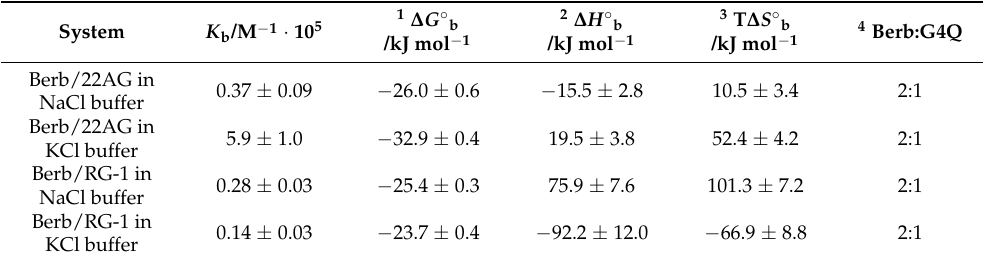
Figure 4. Binding isotherms for the Berb/22AG (panel ( A , B )) and Berb/RG-1 (panel ( C , D )) systems obtained from fluorescence spectroscopy in 30 mM Tris buffer, pH 7.4, with the addition of 100 mM NaCl or KCl. The berberine concentration was 15 µ M and the concentration of G4Qs was varied between 0 µ M and 40 µ M. The berberine was excited at 443 nm, the emission was collected at the maximum of emission, at 536 nm. The red lines represent the best fit of the experimental data according to an equivalent and independent binding sites model. According to the Job’s plot data, the stoichiometry was 2:1 (Berb:G4Q) in all cases. All the experiments were performed at 25 ◦ C and 1 bar. Table 1. Thermodynamics parameters for the complex formation between berberine and 22AG and RG-1 at the indicated solution conditions, at the temperature of 25 ◦ C and pressure of 1